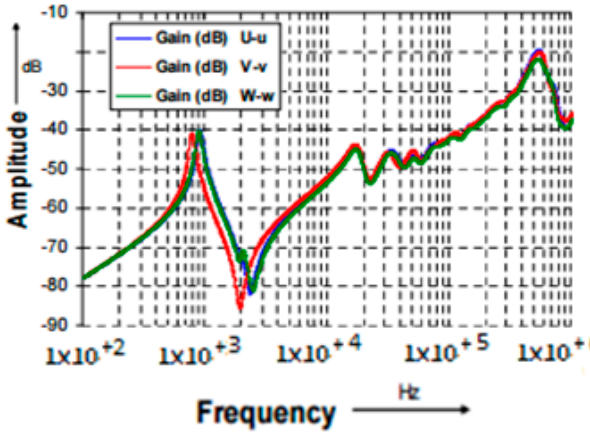
Figure 10. FRA measurement between HV ‐ LV windings for a normal healthy transformer [21].